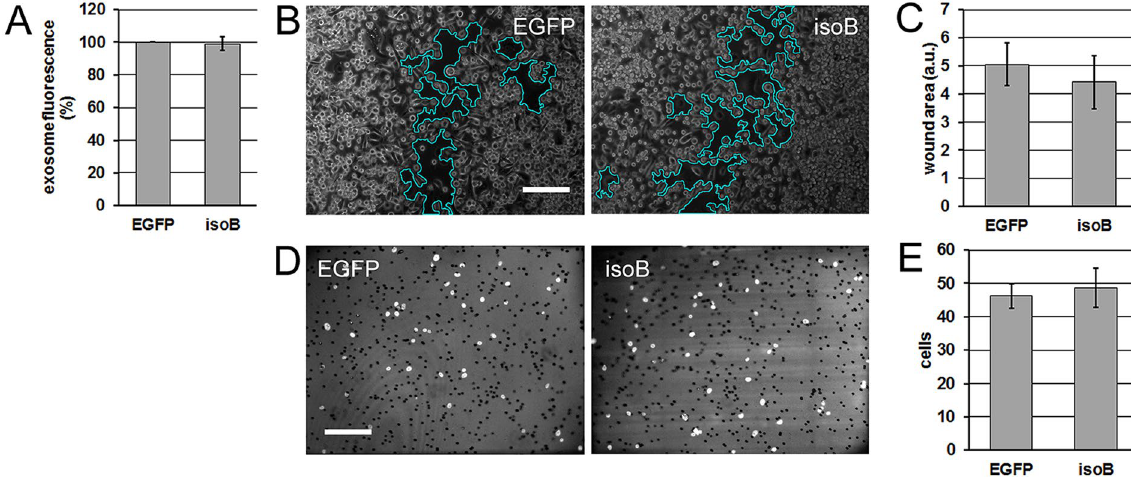
Figure 4. Exosome secretion, motility and invasion of cells overexpressing isoform B. ( A ) Fluorescence of the secreted exosomal fraction (stained with membrane dye Vybrant DiI) from PC3 cells transfected with EGFP alone (control transfection, EGFP ) and EGFP fusion of myosin IC isoform B ( isoB ). Data were normalized to the control. N = 3 cell cultures per group. Experiment was repeated 3 times. Error bar: SE. ( B ) In-vitro wound closure experiment on PC3 transfected with the same constructs. Scratched and healing cell monolayers were photographed in phase contrast 24 h after scratching. Representative fields are shown. Wound area outline in cyan is overlaid by the software used for the automated measurement. ( C ) Quantification of the experiment in ( B ). Error bars: SE. N = 10 camera fields per group. Experiment reproduced 2 times. ( D ) Matrigel invasion experiment. Nuclei of cells that have invaded across the reconstituted extracellular matrix layer were visualized by DAPI staining. Representative fields are shown. ( E ) Quantification of the experiment in ( D ). Error bars: SE. N = 18 camera fields per group. Experiment reproduced 2 times. Scale bars in ( B , D ) – 200 µ